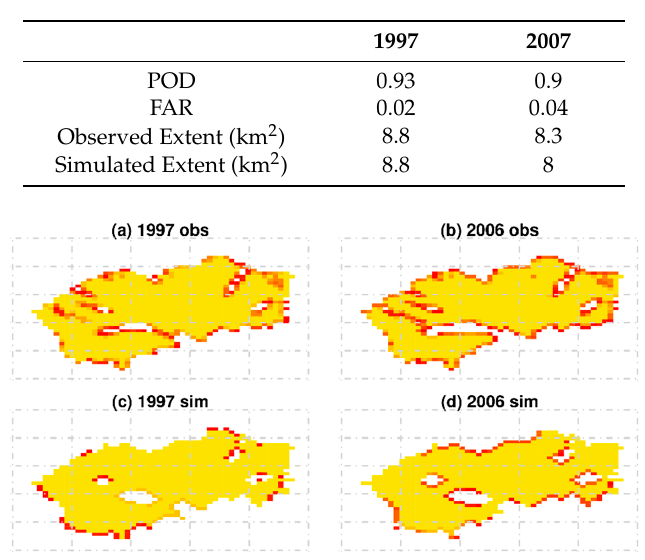
Table 4. Performance measures for observed vs. simulated extents for the Vernagt glacier (POD: probability of detection, FAR: false alarm rate).